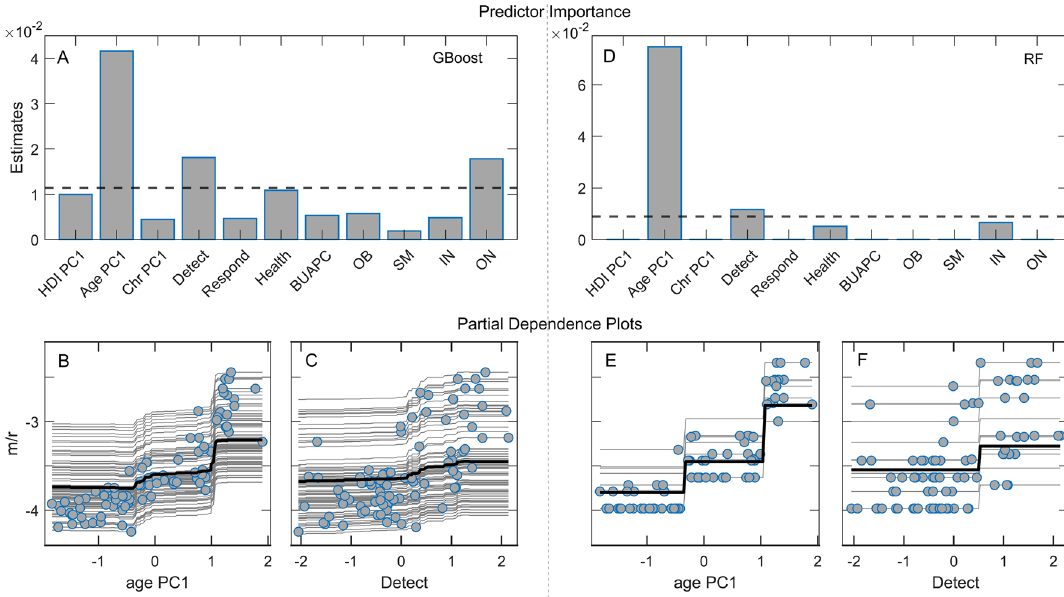
Figure 4. Machine learning algorithms and Partial dependence (PD) plots with disease severity as the response variable. ( A ) Variable importance estimates for Random Forest regression, ( B–C ) PD plots corresponding to Random Forest, ( D ) Variable importance estimates from Gradient Boost regression, ( E–F ) PD plots corresponding to Gradient Boost. The dashed lines in A and D correspond to the mean variable importance in the given model. HDI PC1 – human development index PC1, Chr PC1 – chronic diseases PC1, Detect – GHSI Detect category, Respond – GHSI Respond category, Health – GHSI Health category, BUAPC – built-up